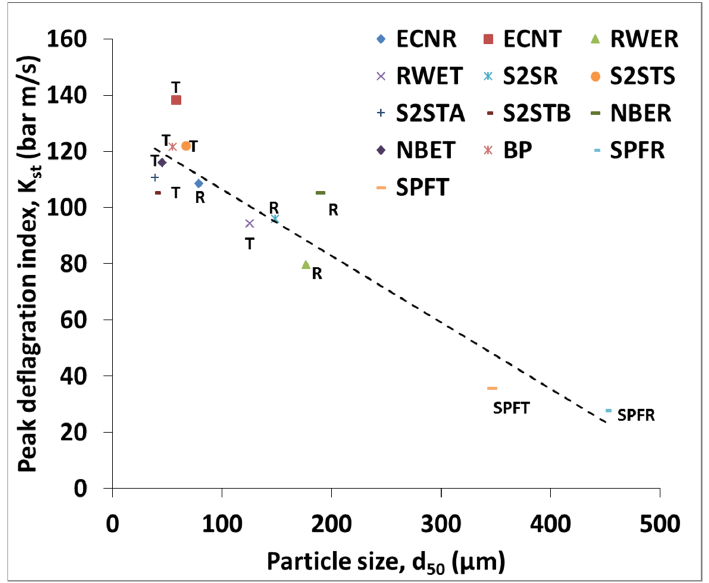
Figure 8. Peak deflagration Index (Kst, max) vs. average size for 50% fraction (d50) for present samples in comparison to other results of raw (R) and thermally treated samples (T) [30,39,42,58,59].